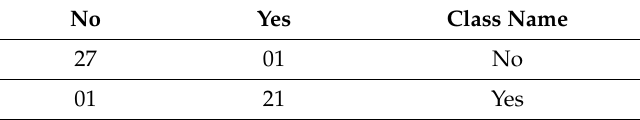
Table 15. Matrix with reduced dimensions for fold 4.